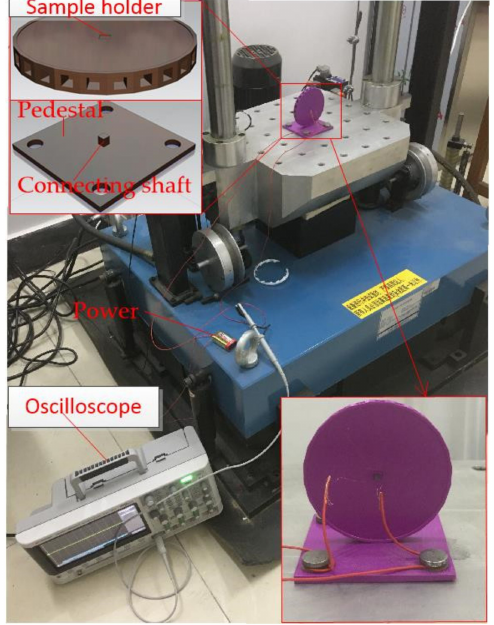
Figure 8. The dropping hammer